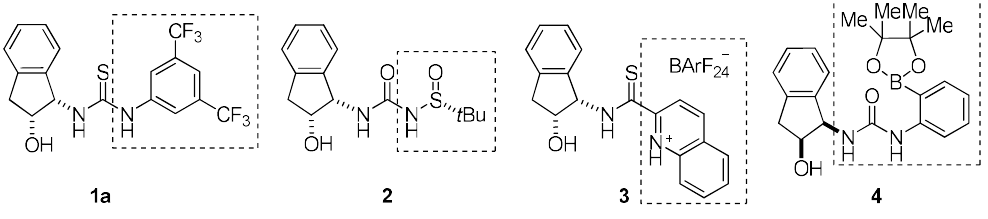
Figure 1. Comparative variation of acidity in (thio)urea structures.